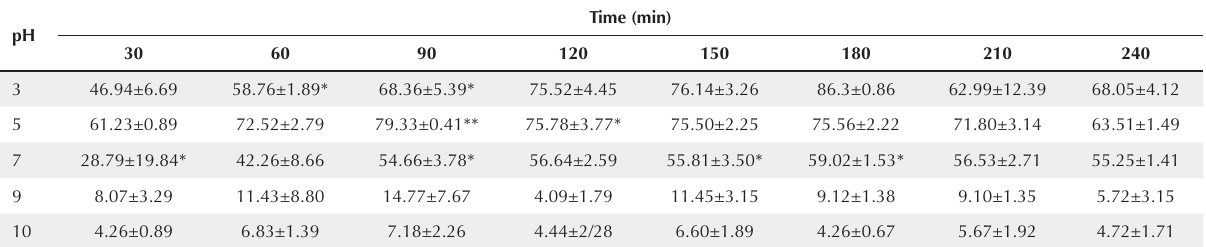
-N-S photocatalyst 2